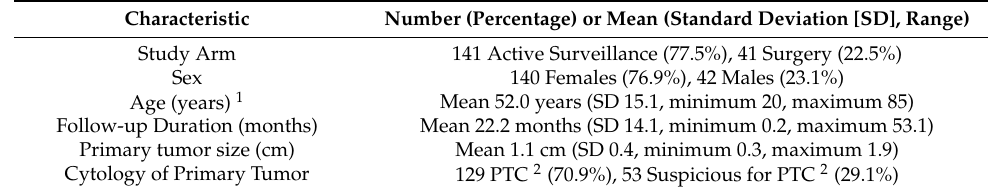
Table 1. Clinical and demographic characteristics of the 182 study participants.